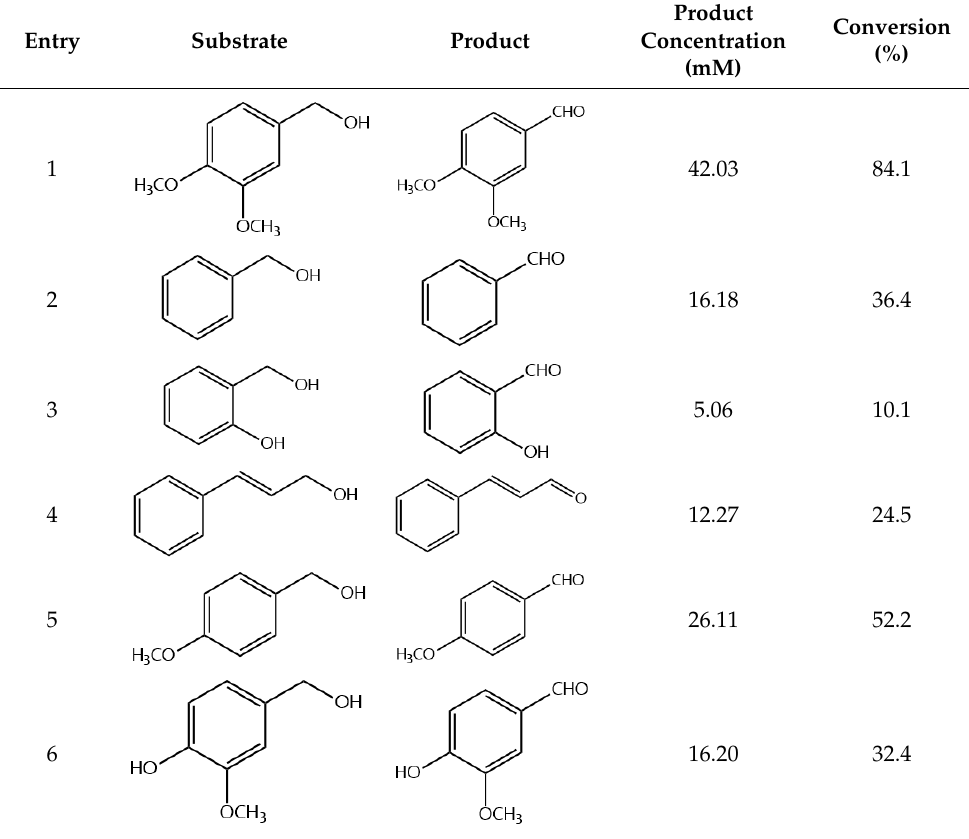
Figure S3: Effect of pH on Pe AAOx enzyme activity (A) and tolerance of Pe AAOx to pH (B); Figure S4: Gas chromatograms of different Pe AAOx enzyme dosages used to catalyze the reaction of aromatic primary alcohols for 24 h; Figure S5: Gas chromatograms of different Aae UPO